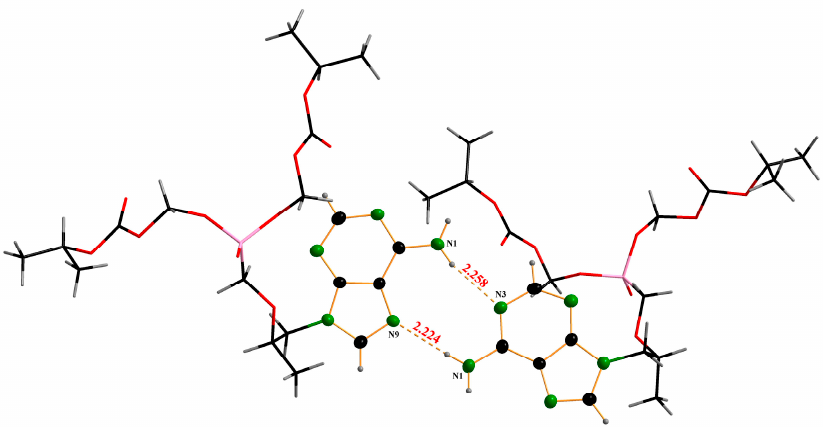
Figure 3. Intermolecular hydrogen bond between nitrogen atoms for Tenofovir disoproxil (TD) free base.